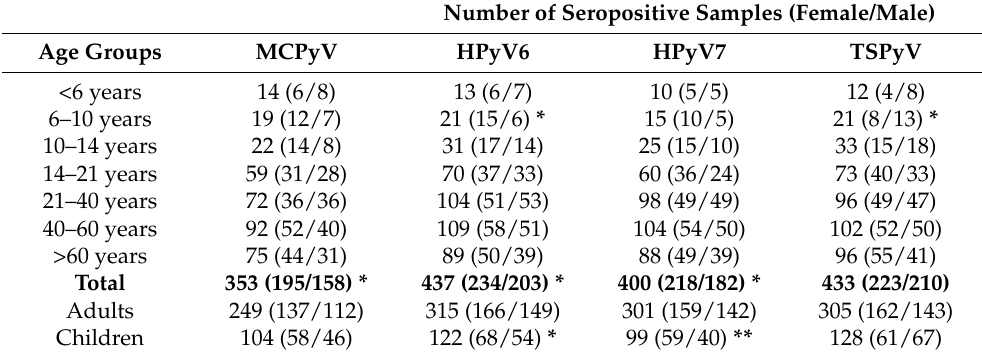
Table 2. Seroprevalence of MCPyV, HPyV6, HPyV7 and TSPyV by age group and